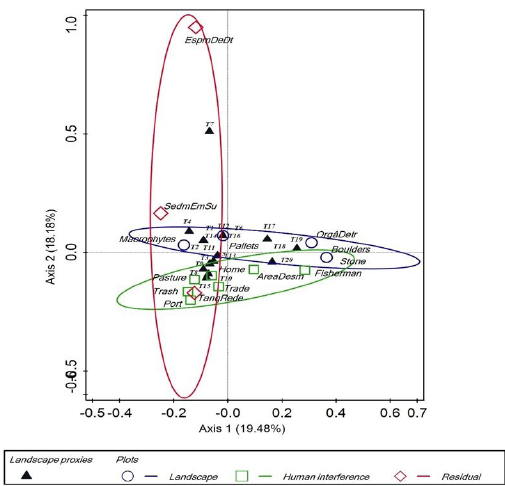
Figure 5. Ordering diagram of the Canonical Correspondence Analysis (CCA) showing the sample transects, limnological signatures and the Proxy of the landscape in the Curuá-Una reservoir, in November 2016. Legend: T = Transects; SedmEmSu = Suspended sediment; OrgâDetr = Organic matter/debris; EspDeDet =